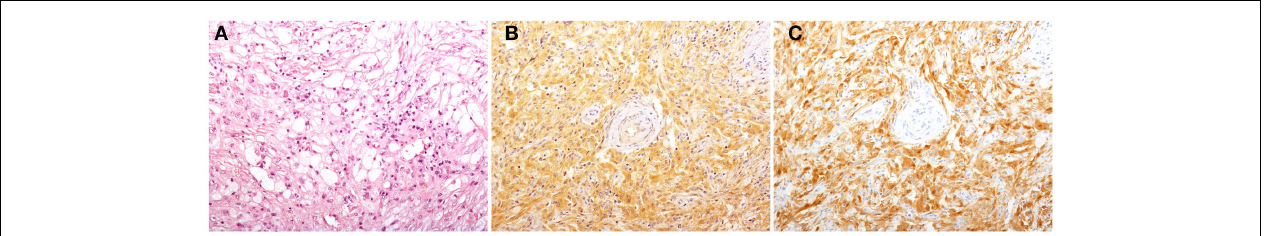
FIGURE 1 | Histological findings in patients with Erdheim–Chester disease (ECD) . Histology shows a xanthogranulomatous infiltrate composed by foamy histiocytes accompanied by fibrosis [ (A) , H&E, original